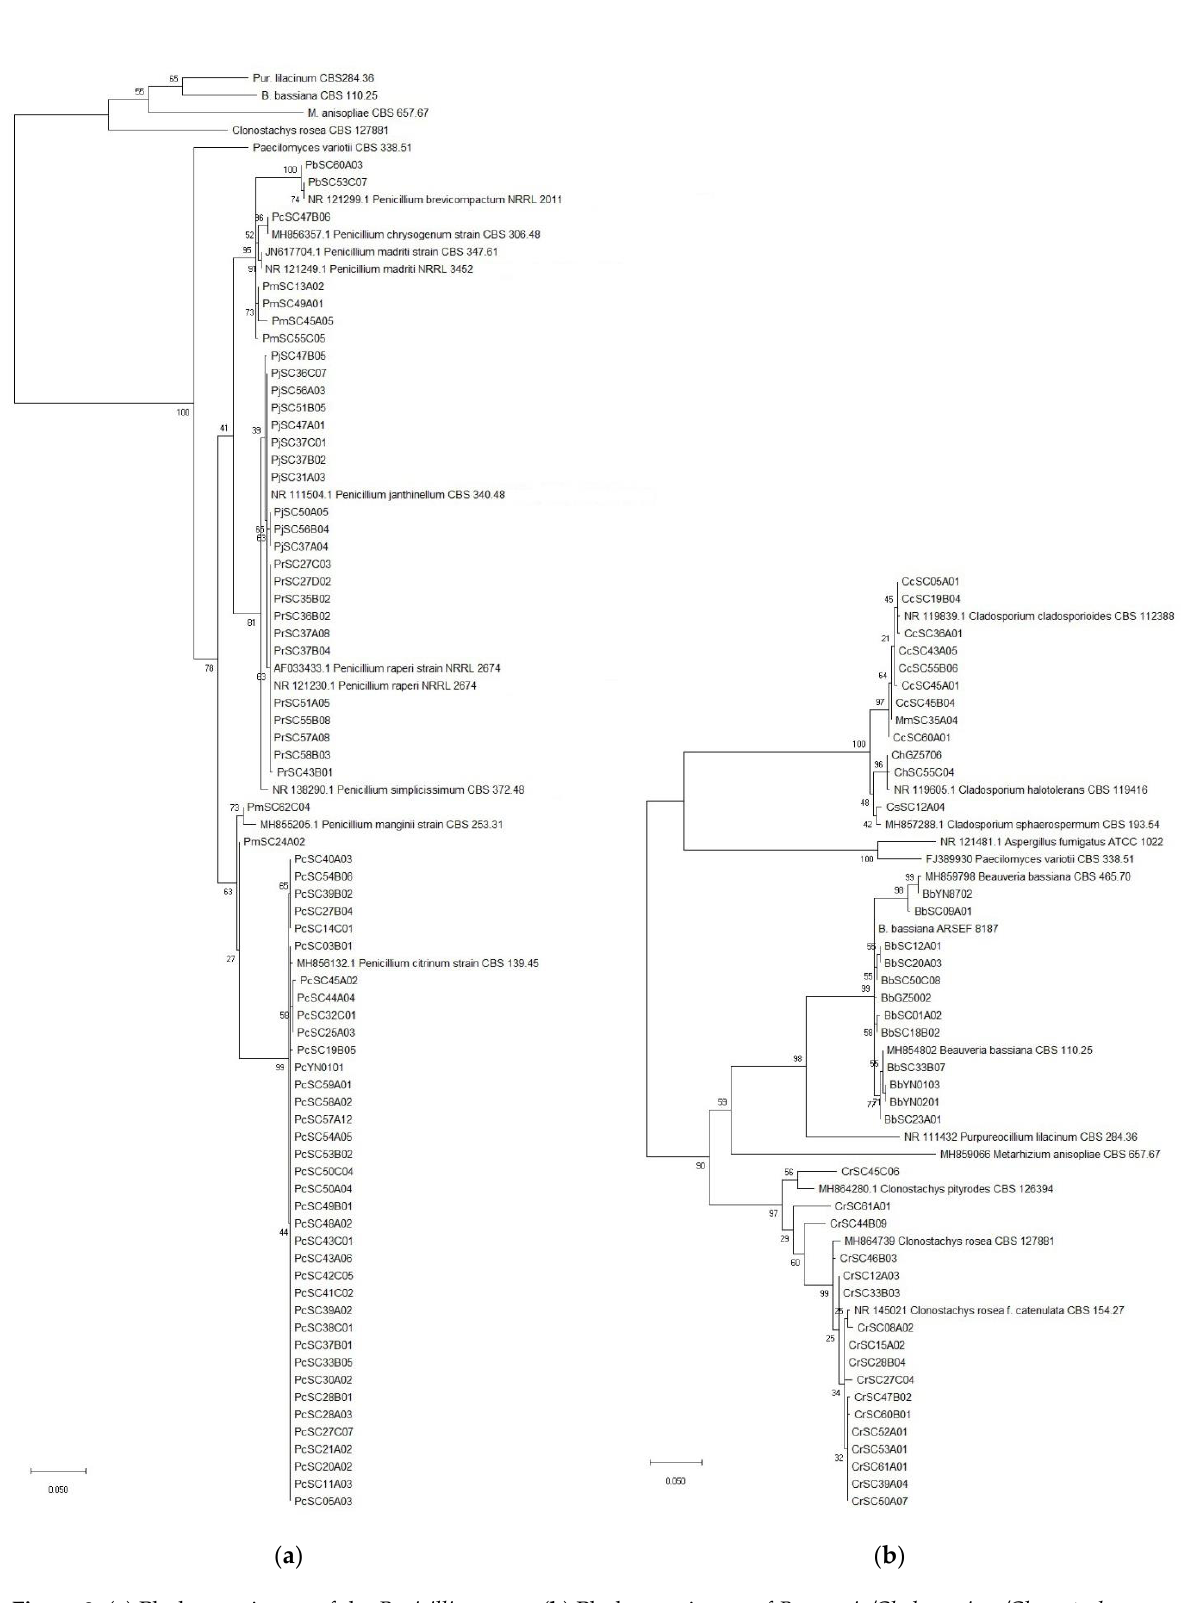
Figure 3. ( a ) Phylogenetic tree of the Penicillium spp.; ( b ) Phylogenetic tree of Beauveria/Cladosporium/Clonostachys spp.